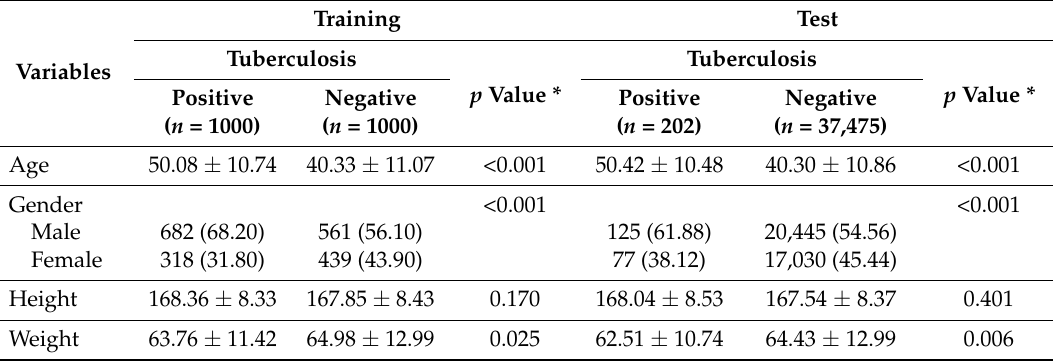
Table 1. Summary of demographic variables for training and test datasets.